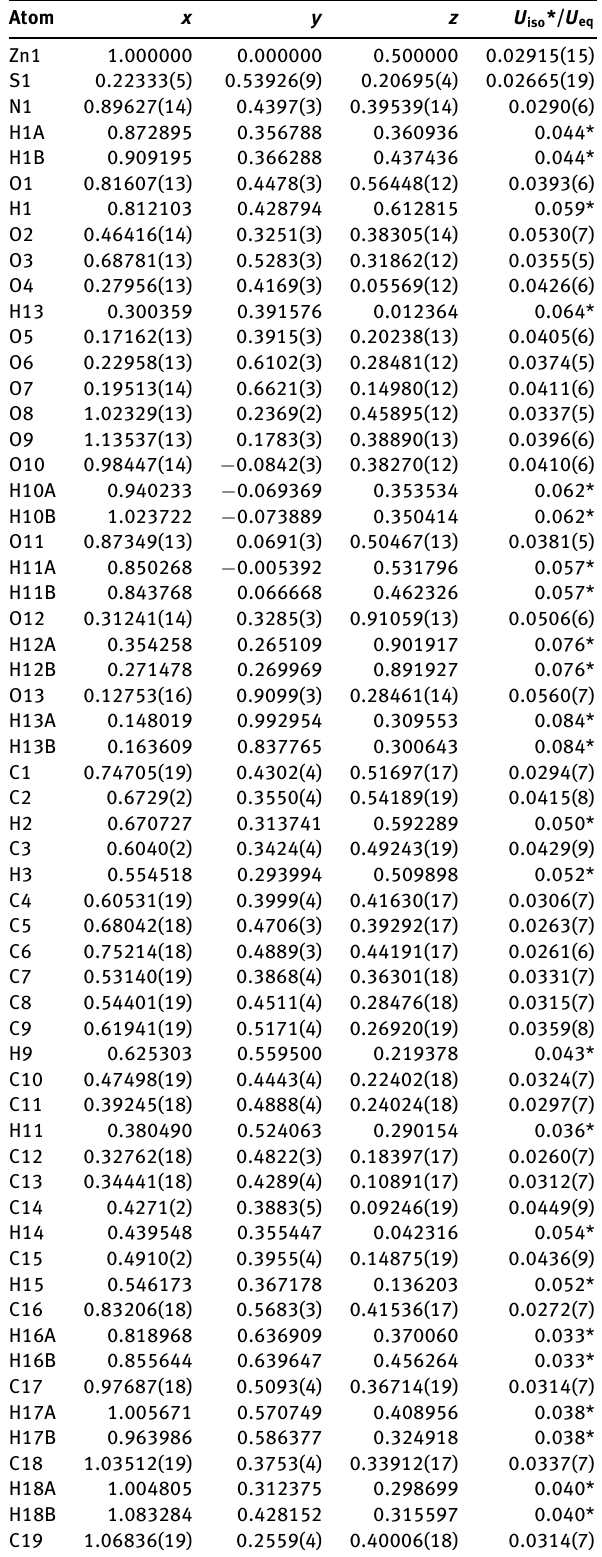
Table 2: Fractional atomic coordinates and isotropic or equivalent isotropic displacement parameters (Å 2